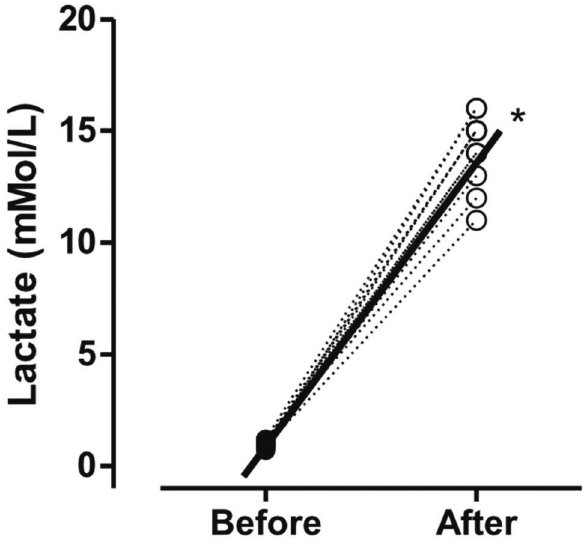
Figure 2 - Values are presented as the means ± standard devia- tions. * p o 0.001 vs .